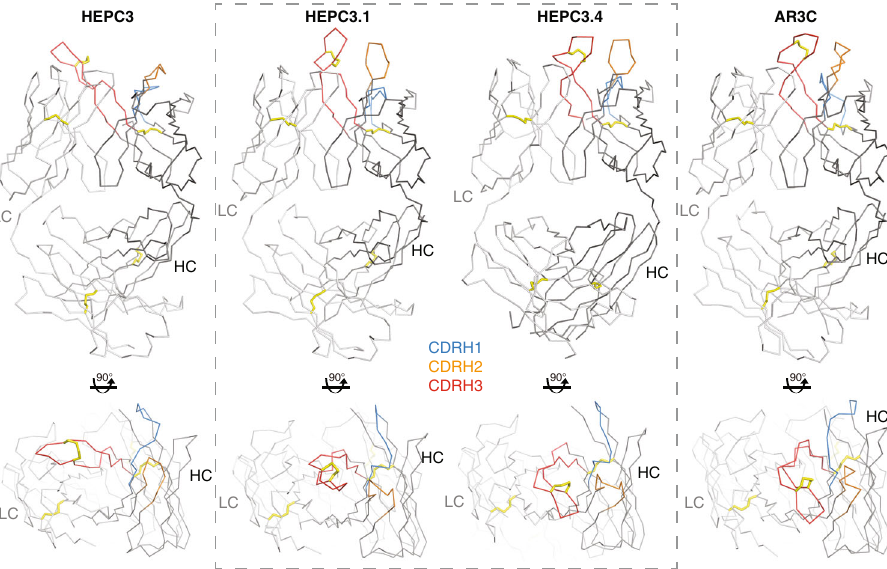
Fig. 3 The HCDR3 loop in HEPC3.1 and HEPC3.4 Abs adopts a bent orientation. Side (top) and top (bottom) views of Fab apo structures of HEPC3 (PDB ID: 6MED), HEPC3.1 (this study), HEPC3.4 (this study), and AR3C (PDB ID: 6MEF). The crystal structures were superimposed on their V H domains. Protein backbones are shown as ribbons, and CDR loops are blue (HCDR1), orange (HCDR2), and red (HCDR3). Disul fi de bonds are shown as yellow